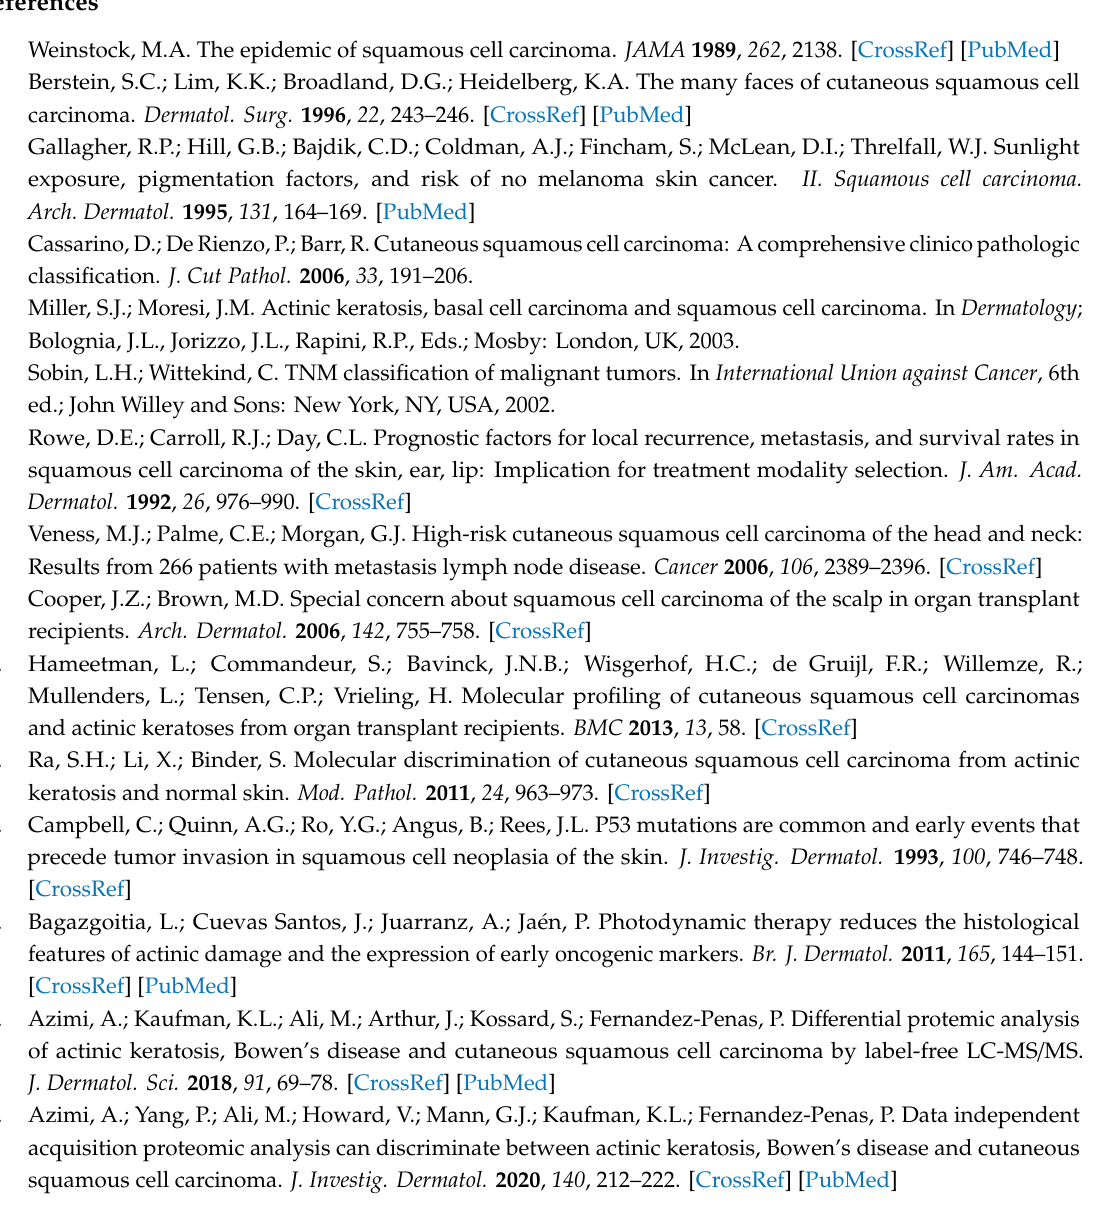
Table S1: Characteristics of the patients, controls and skin samples, Table S2: Comparison of the protein expression profile in normal skin (controls) and SCC-AK, Table S3: Spearman associations between level of SCC infiltration and the protein expression level of Hsp27, Hsp70 and